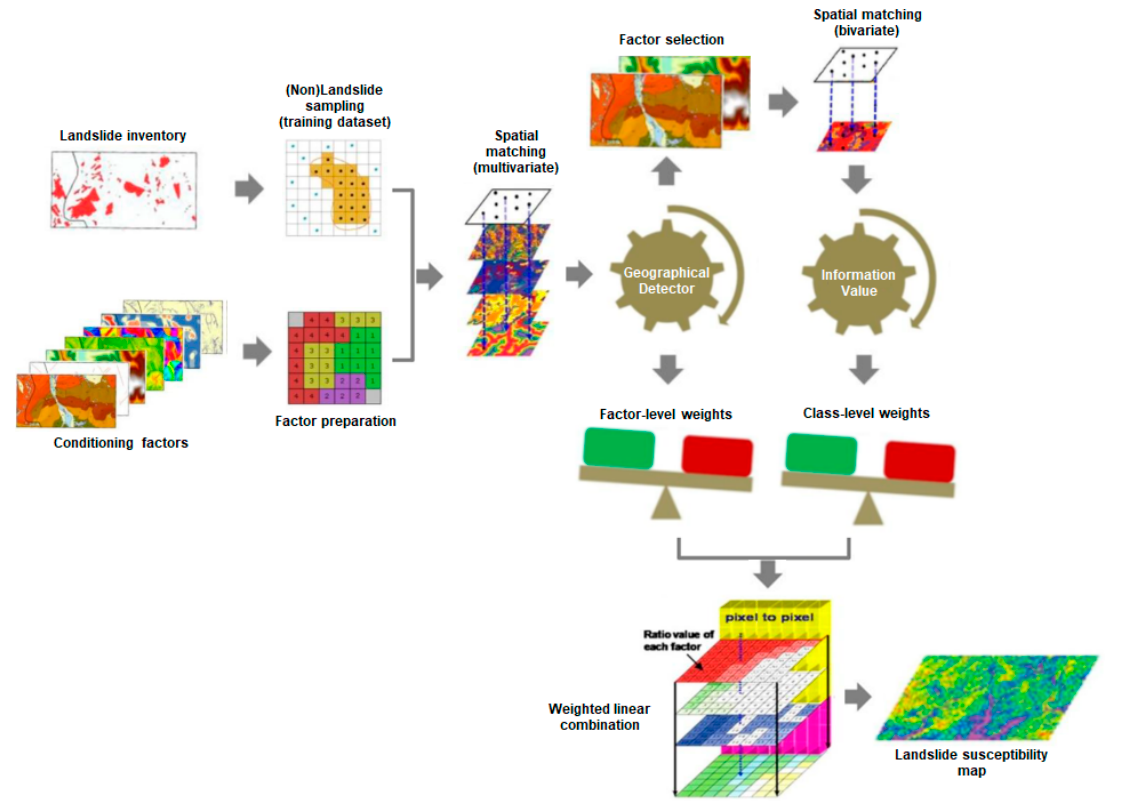
Figure 3. Methodological framework for the development of the hybrid GeoDIV model.